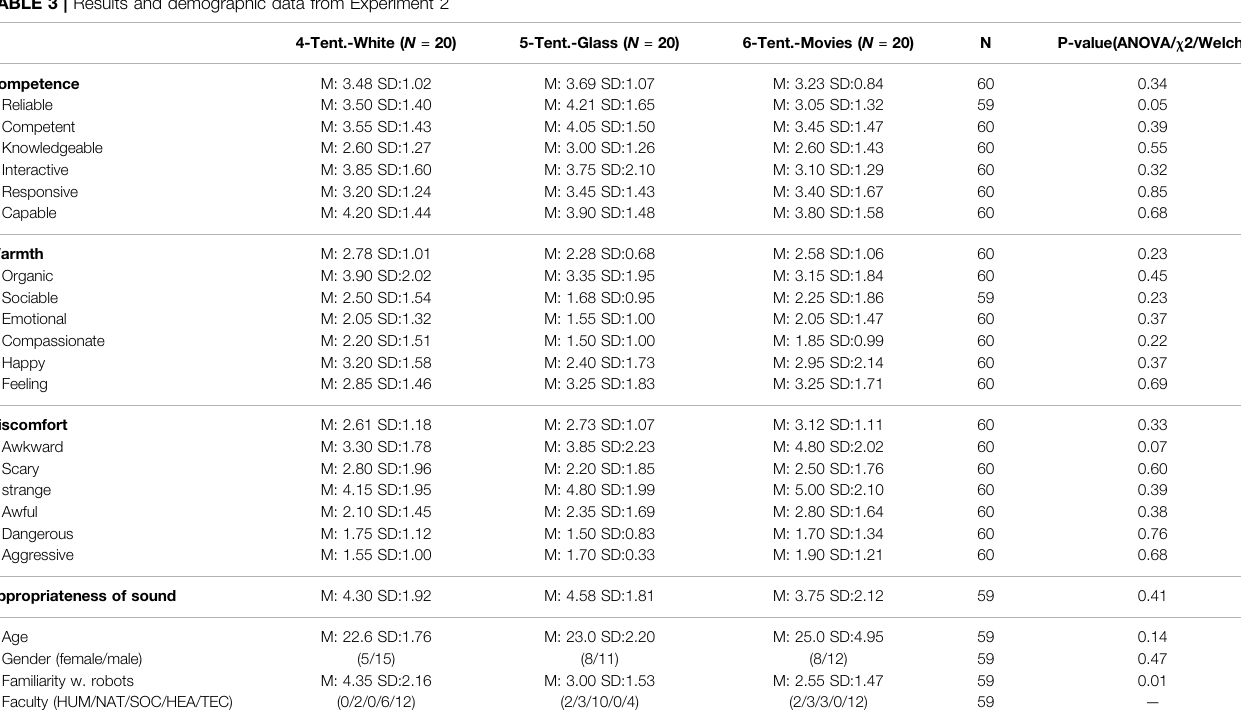
TABLE 3 | Results and demographic data from Experiment